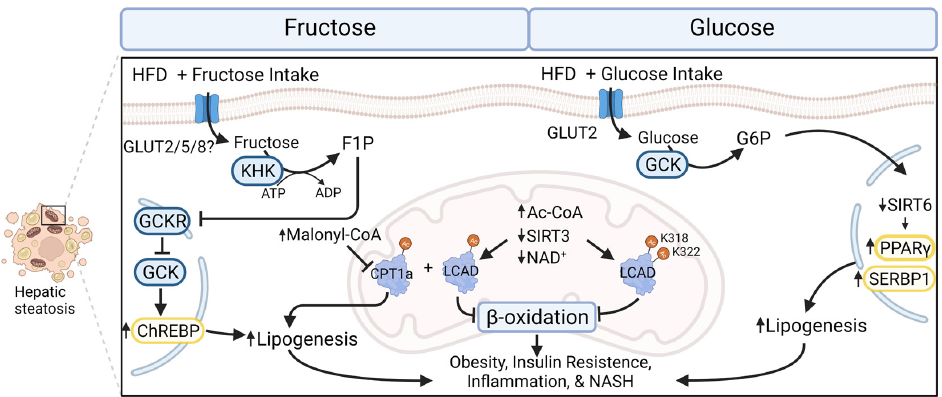
Figure 4. Fructose and glucose metabolism in combination with HFD are connected to negative health outcome consistent with MetS. Fructose upon cellular uptake by GLUT2, 5 and possibly 8, is catabolized to F1P by KHK using the cofactor ATP. In contrast, glucose is metabolized to G6P by GCK which is inhibited by GCKR [125]. KHK is not allosterically inhibited resulting in the excess generation of F1P in hepatocytes [126]. F1P can interfere with GCK inhibition by dislocating its binding partner GCKR. Resulting in the induction of the transcription factor ChREBP, resulting in increased lipogenesis [126]. Fructose consumption also induces hyperacetylation of CPT1a and LCAD which leads to decreased lipid metabolism [69]. Fructose metabolism is also connected to elevated concentrations of malonyl-CoA which inhibits CPT1a, reducing mitochondrial lipid uptake. Glucose consumption results in the acetylation of LCAD and decreased beta-oxidation [73]. Glucose consumption is also associated with the decreased SIRT6 abundance and increased lipogenesis